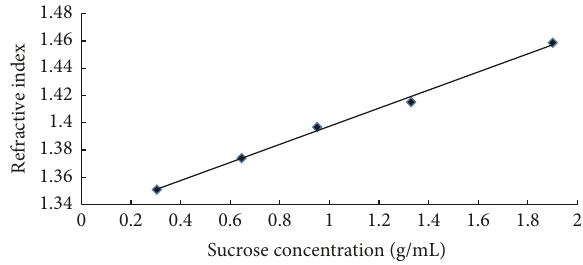
Figure 1: Calibration curve for the refractometer.